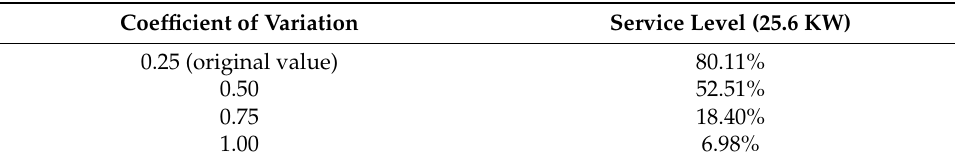
Table 7. S ervice level varying the CV value for the M x /M/∞ model. Table 7. Service level varying the CV value for the M x /M/ ∞